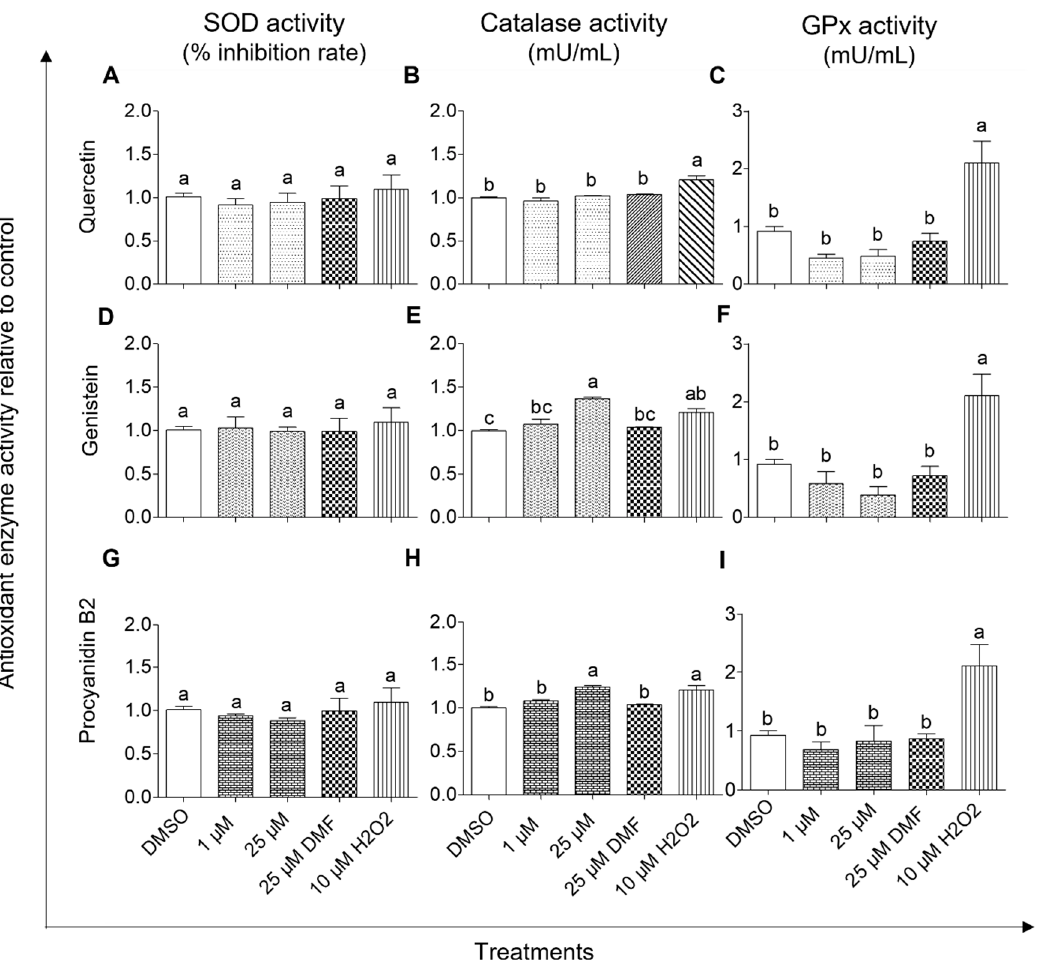
Figure 11. Effect of quercetin ( A – C ), genistein ( D – F ), and procyanidin B2 ( G – I ) on antioxidant enzyme (superoxide dismutase, catalase, and glutathione peroxidase) activities in BEAS-2B cells. Cells were treated with 1 µ M or 25 µ M of quercetin, genistein, or procyanidin B2 for 3 h. DMF (25 µ M) and H 2 O 2 (10 µ M) were used as the positive controls, and 0.1% DMSO was used as the vehicle control. Effects of tested compounds on the activity of SOD, catalase, and GPx were assessed. Three independent studies (each done in duplicate) were performed, and results were expressed as mean ± standard deviation. Statistical analysis of data was performed by one-way ANOVA and mean comparison was done by Tukey’s mean comparison method ( α = 0.05) using Minitab 19 statistical software (LLC, Pennsylvania, USA). Mean values that do not share similar letters (i.e., (a–c)) in bar graphs are significantly different ( p < 0.05). Abbreviations: DMF: dimethyl fumarate DMSO: dimethyl sulfoxide, H 2 O 2 : hydrogen peroxide, GPx: glutathione peroxidase, SOD: superoxide dismutase.